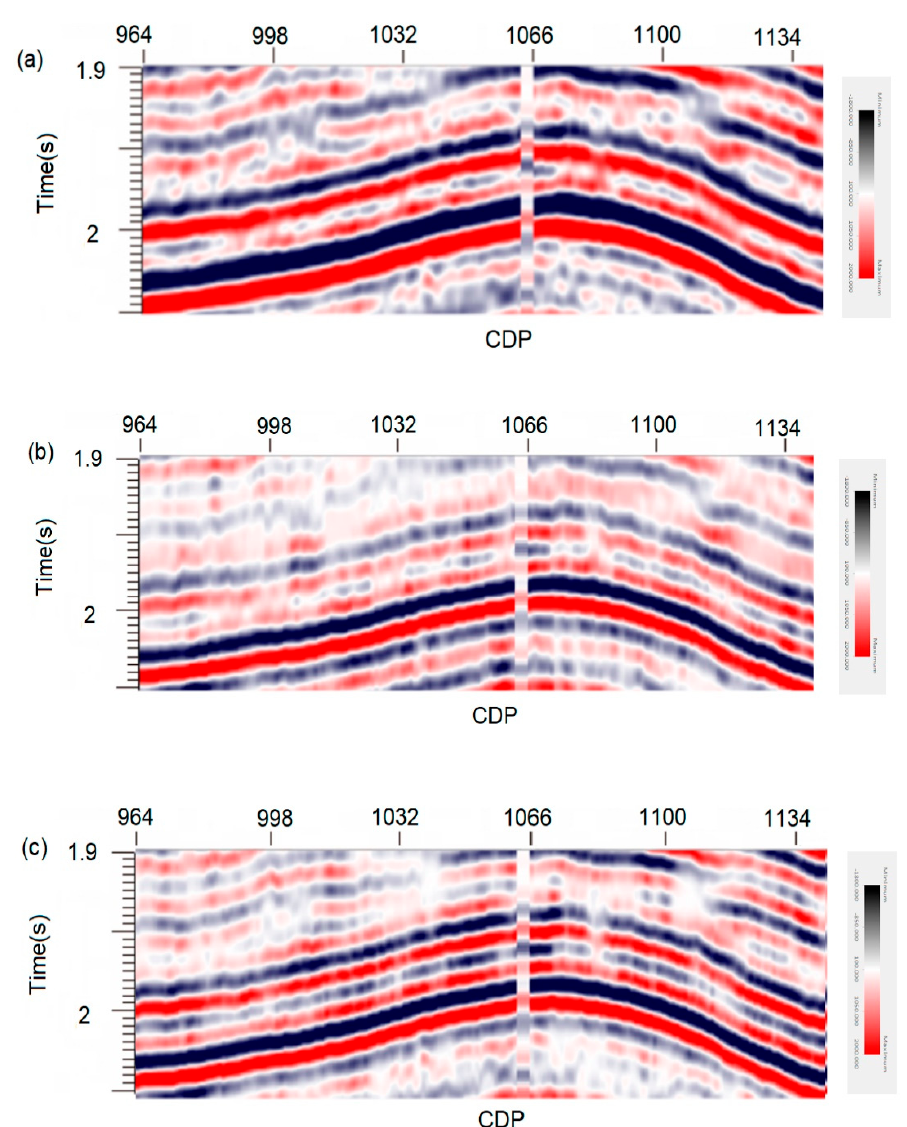
Figure 14. Enlarged views of the same portions of the previous sections that allow appreciate the location of the seismic reflectors delineated by the tested algorithms: ( a ) real field data; ( b ) image recovered by conventional ISTA; and, ( c ) section processed by the algorithm proposed in this study.